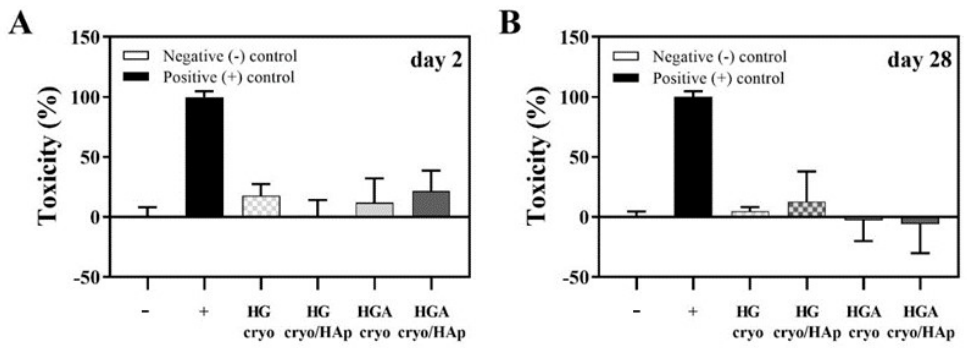
Figure 5. Cytotoxicity of scaffolds (HG cryo , HG cryo /HAp, HGA cryo , HGA cryo /HAp) on seeded hMSCs as determined by LDH activity in culture media collected after 2 ( A ) or 28 days ( B ) days. Values represent mean ± SD ( n = 4).